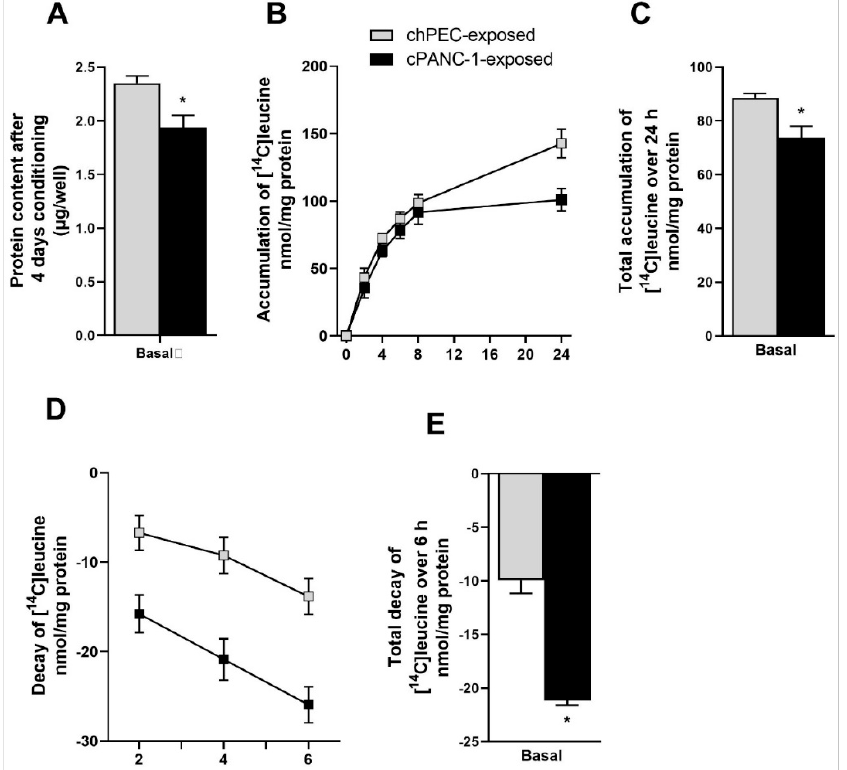
Figure 1. Incorporation and decay of leucine in myotubes after conditioning with medium collected from hPECs or PANC-1 cells. Myotubes were conditioned with the medium from human pancreatic epithelial cells (chPEC exposed) or a human pancreatic cancer cell line (cPANC-1 exposed) during the last 4 days of differentiation. ( A ) Protein content was measured using Bradford protein assay. Muscle cells were incubated with [ 14 C] leucine (37 kBq, 0.8 mmol/l), and ( B ) cellular accumulation of leucine was measured over 24 h by scintillation proximity assay (SPA). ( C ) Overall accumulation of [ 14 C] leucine was calculated as the area under the curve. ( D ) The medium was then changed to label-free medium, and decay of radioactivity was measured over 6 h by SPA. ( E ) Overall decay over 6 h was calculated as the area under the curve. Data are presented as the mean ± SEM from four individual experiments, each with three replicates ( n = 12). * Statistically significant for cPANC-1-exposed myotubes versus chPEC-exposed myotubes ( p ≤ 0.05, SPSS linear mixed-model analysis).